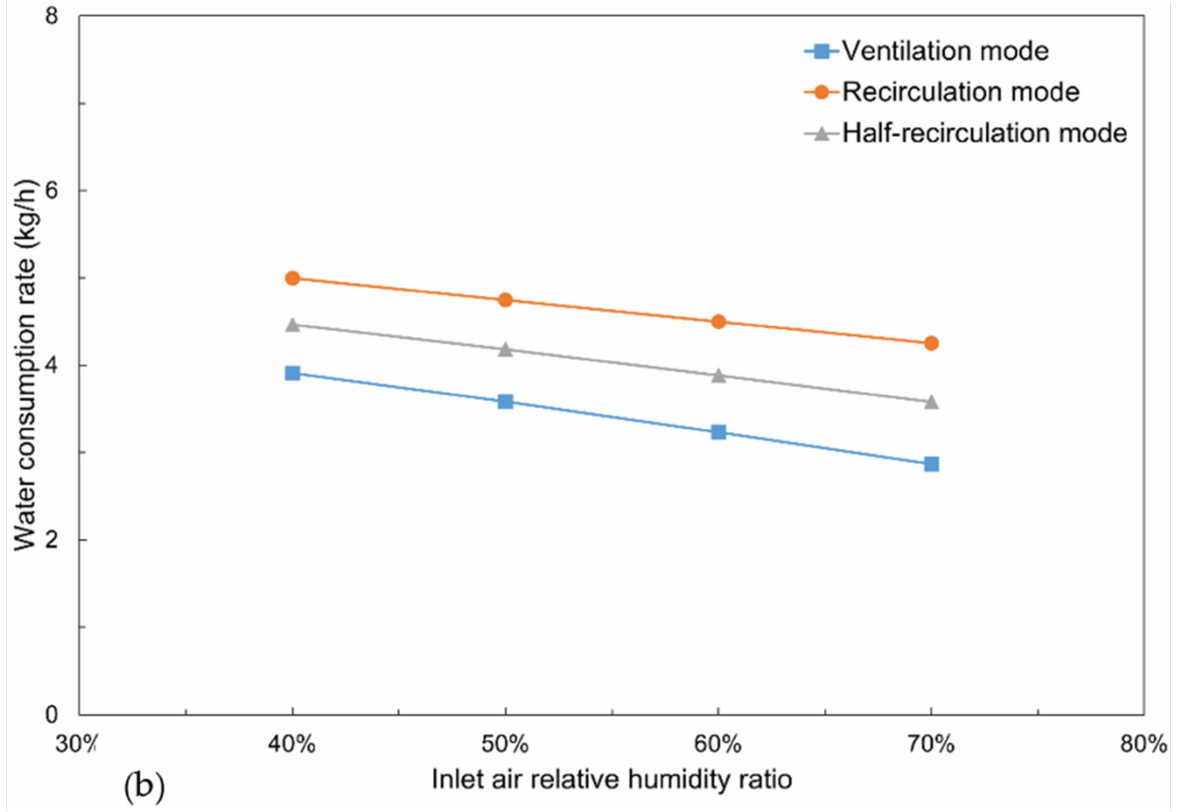
Figure 8. Effects of outdoor air ( a ) temperature and ( b ) humidity on water consumption